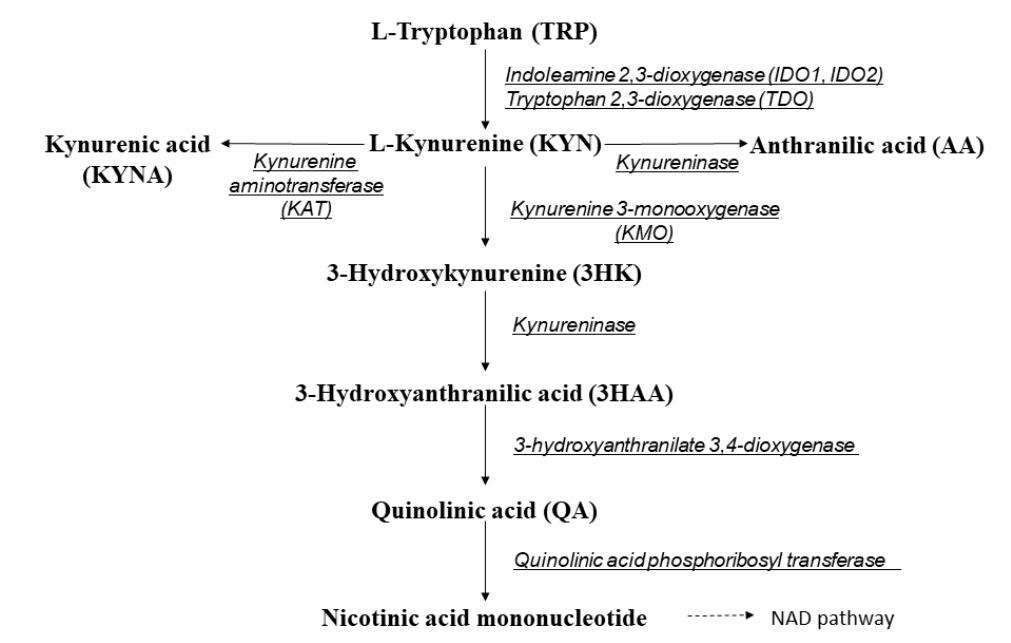
Figure 1. The KYN pathway of TRP degradation. NAD: nicotinamide adenine dinucleotide